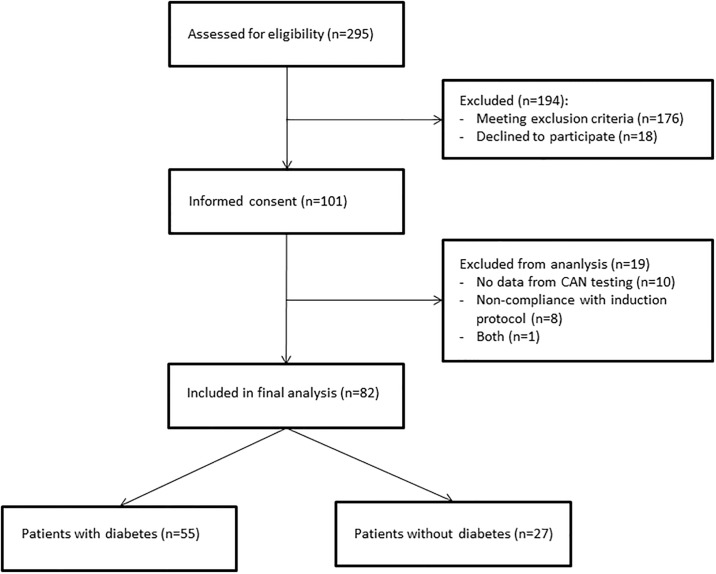
Flow chart of study.